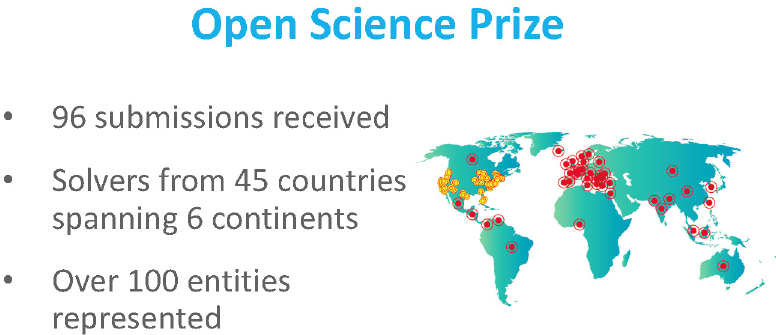
Fig 1. The 6 Phase I finalists were: (a) “OpenAQ: A Global Community Buildingthe First Open, Real-TimeAir Quality Data Hub for the World,” providingreal-time informationon poor air quality by combiningdata from across the globe,(b) “OpenTrialsFDA: Making UnbiasedClinicalTrial Data Accessible,”enablingbetter access to drug-approval packagessubmitted to and made available by the Food and Drug Administration, (c) “Open Neuroimaging Laboratory,” advancingbrain researchby enablingcollaborative annotation,discovery, and analysisof brain-imaging data, d) “Fruit Fly Brain Observatory,” allowingresearchers to better conduct modeling of mental and neurologicaldiseasesby connecting data related to the fly brain, (e) “MyGene2: Accelerating Gene Discoveryvia RadicallyOpen Data Sharing,”facilitatingthe public sharing of healthand geneticdata through integrationwith publiclyavailableinformation, and (f) “Real-Time EvolutionaryTracking for PathogenSurveillance and EpidemiologicalInvestigation,” permitting real-time analysisof emerging epidemics, such as Ebola, Middle East Respiratory Syndrome Conavirus,and